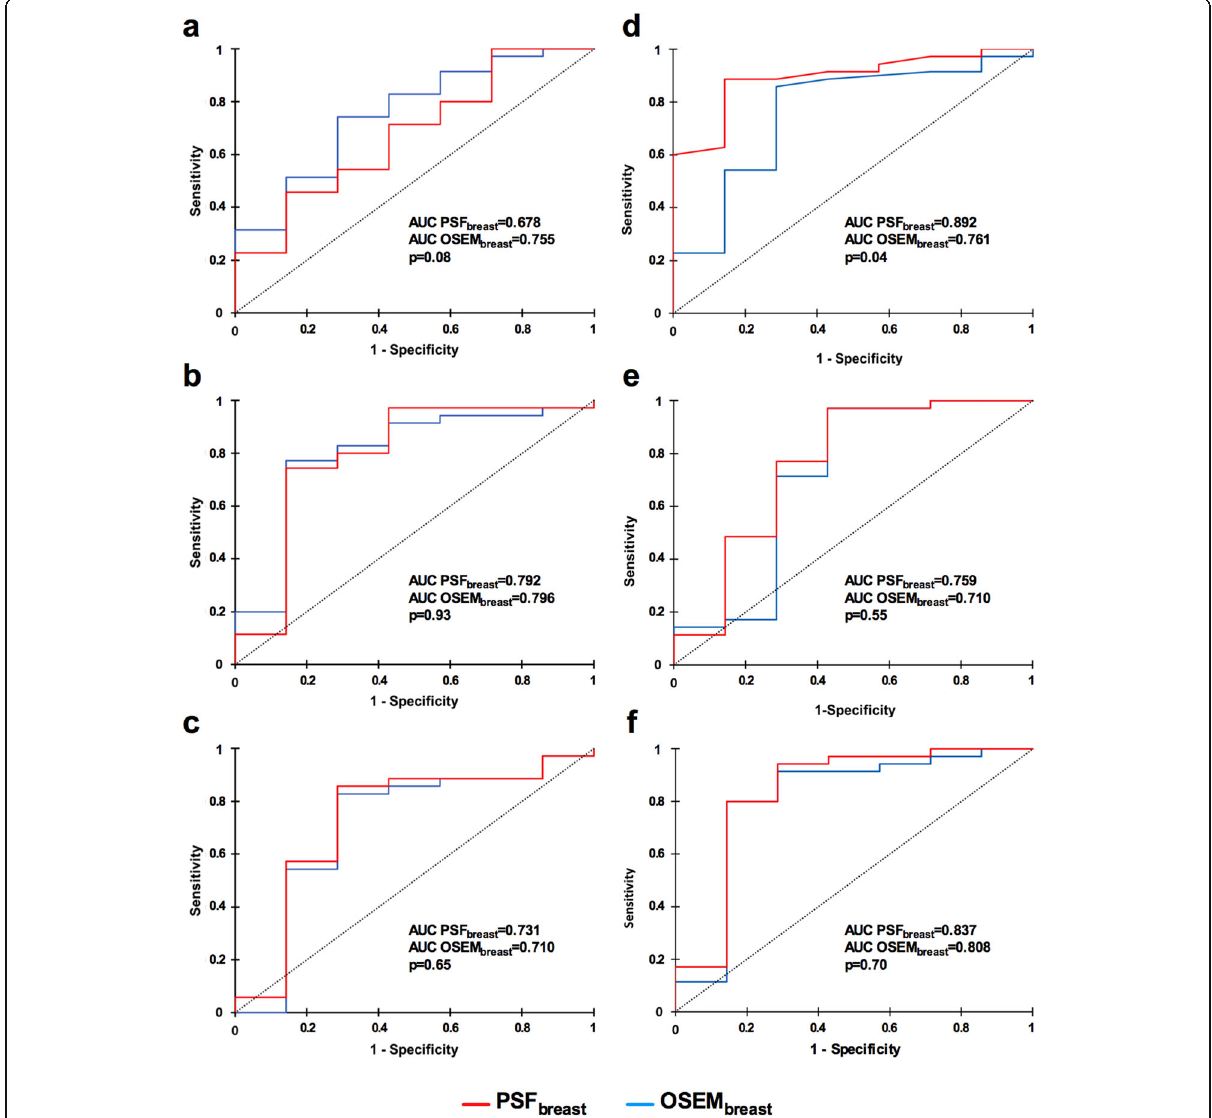
Fig. 5 ROC curves for SUV mean ( a ), SUV max ( b ), MTV ( c ), coarseness ( d ), GLNU ( e ) and ZLNU ( f ) values. The blue line corresponds to OSEM breast and the red one to PSF breast